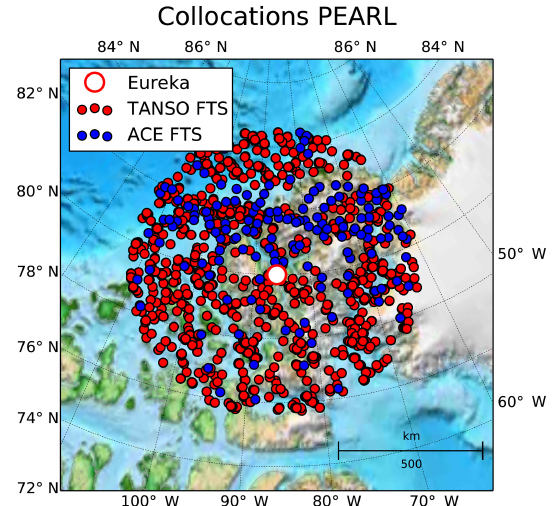
Figure 1. Geographic map showing northeastern Nunavut (Canada), northwestern Greenland, and surrounding islands, in a Lambert azimuthal equal-area projection (Lambert, 1772). The background shows bathymetry in blue tones, elevation in green and brown tones, and land ice with areas larger than 100km 2 in white, as calculated by NOAA ETOPO1 (Amante and Eakins, 2009). The white circle with a red edge in the centre of the map shows the lo- cation of the PEARL Ridge Lab near Eureka, Nunavut. The red and blue dots with black edges show the locations of TANSO-FTS and ACE-FTS profiles within 500km and 24h of PEARL, in the time period indicated in Table